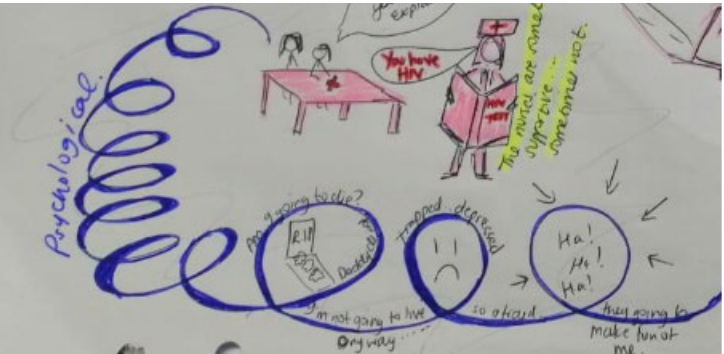
Figure 8: Psychological reaction to positive HIV result